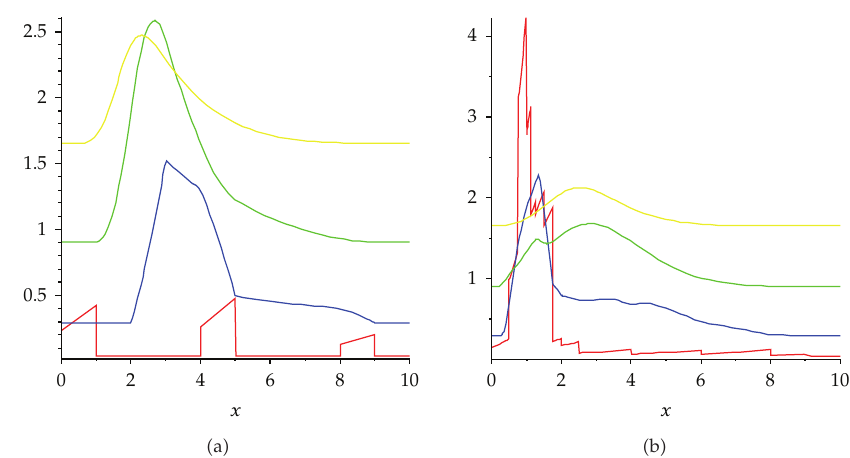
Figure 6: Experiment with the coupled model for the immobile solutions c im , with j (cid:9) 2 and j (cid:9) 4 iteration steps at time point t (cid:9) 8.